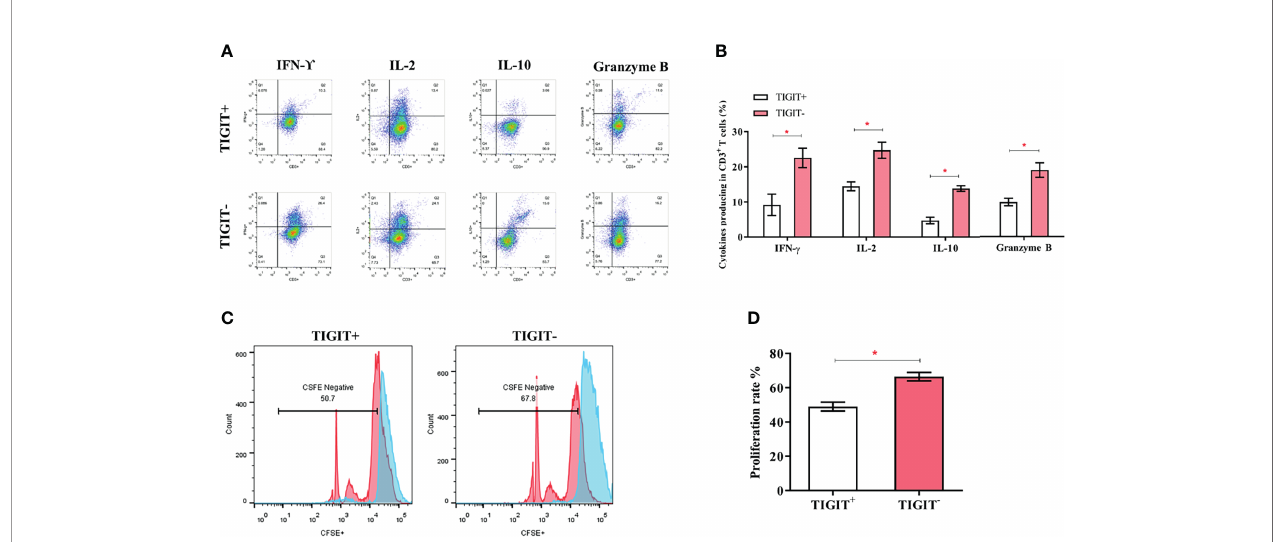
FIGURE 2 | TIGIT impairs CD3 + T cells ’ function and leads to a reduced proliferation rate. The frequency of IFN- g , IL-2, IL-10, and GranzymeB secreting of CD3 + T cells was detected by FACS. (A) Typical fl ow cytometry images in CD3 + TIGIT + T cells and CD3 + TIGIT - T cells. (B) Data was shown from three experiments conducted in 6 samples. (C) Cells were stained with CFSE, and proliferation rates were detected by FACS. Representative histograms are shown. (D) Proliferation of CD3 + TIGIT + T cells and CD3 + TIGIT - T cells. (* P < 0.05).